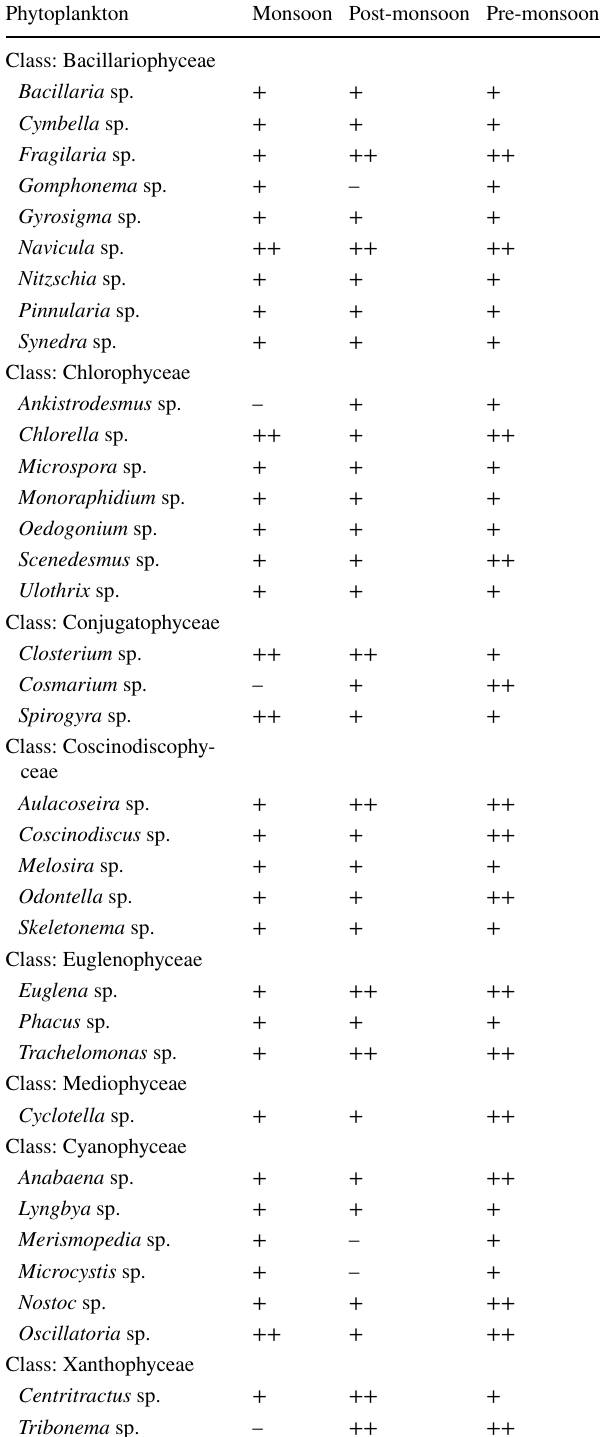
Table 3 Microfloral profile of Kailash Khal wetland (generic level)